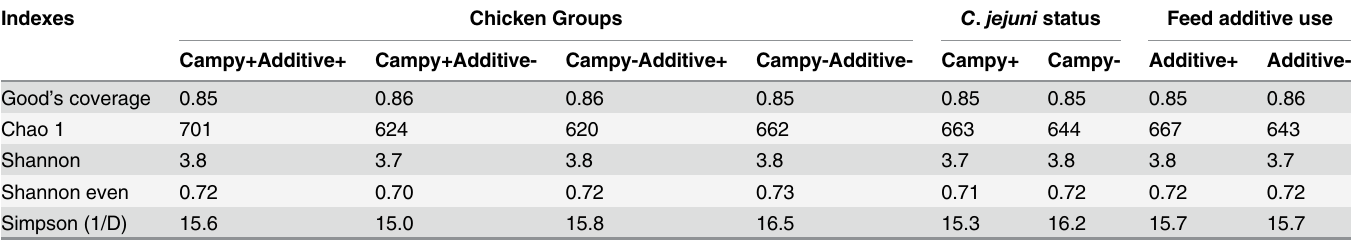
Table 1. Comparison of alpha-diversity indexes across chicken groups and according to C . jejuni colonization or to feed additive use. Indexes Chicken Groups C . jejuni status Feed additive